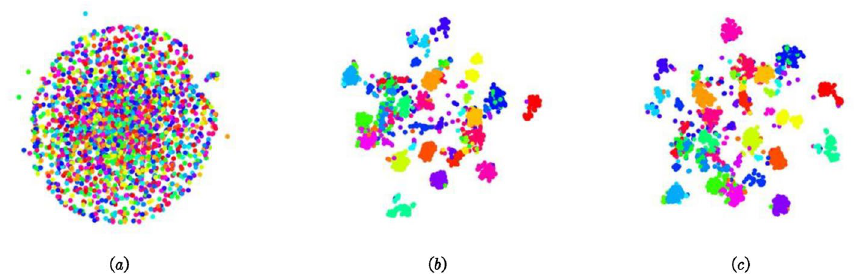
Figure 6. ( a ) Original ModelNet40 dataset. ( b ) DGCNN’s output (c) ATDGCNN’s